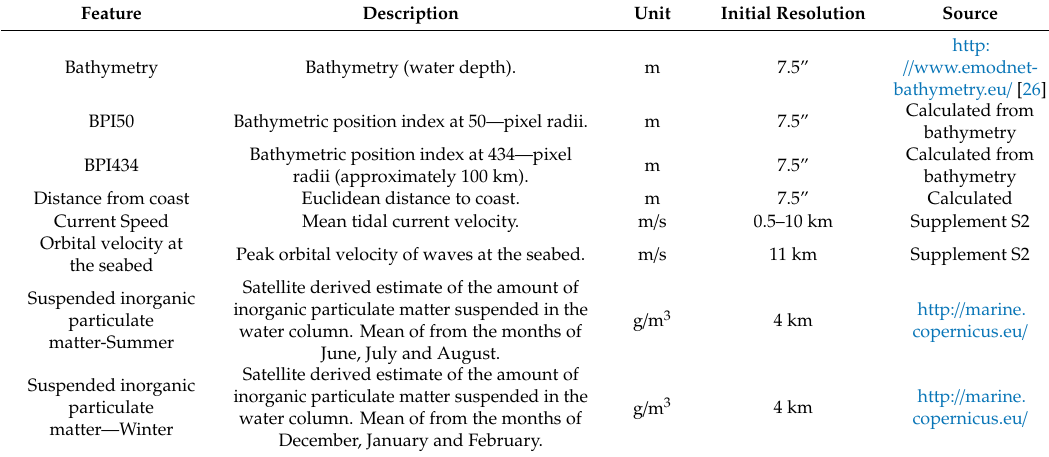
Table 1. Predictor variables used to model the distribution of